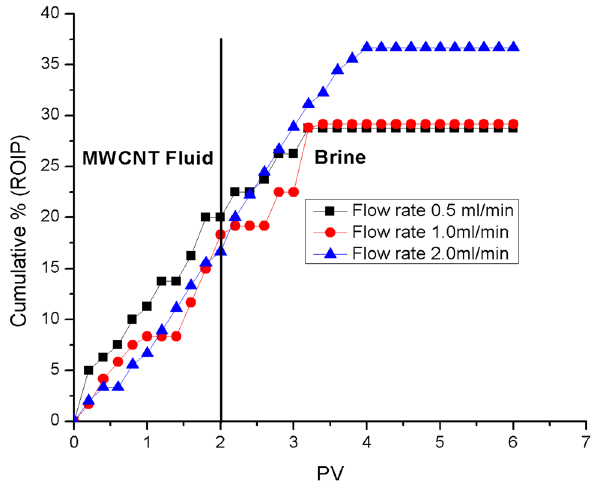
Fig. 1 Comparison of the cumulative ROIP versus pore volume of MWCNT fluid injected in the porous medium